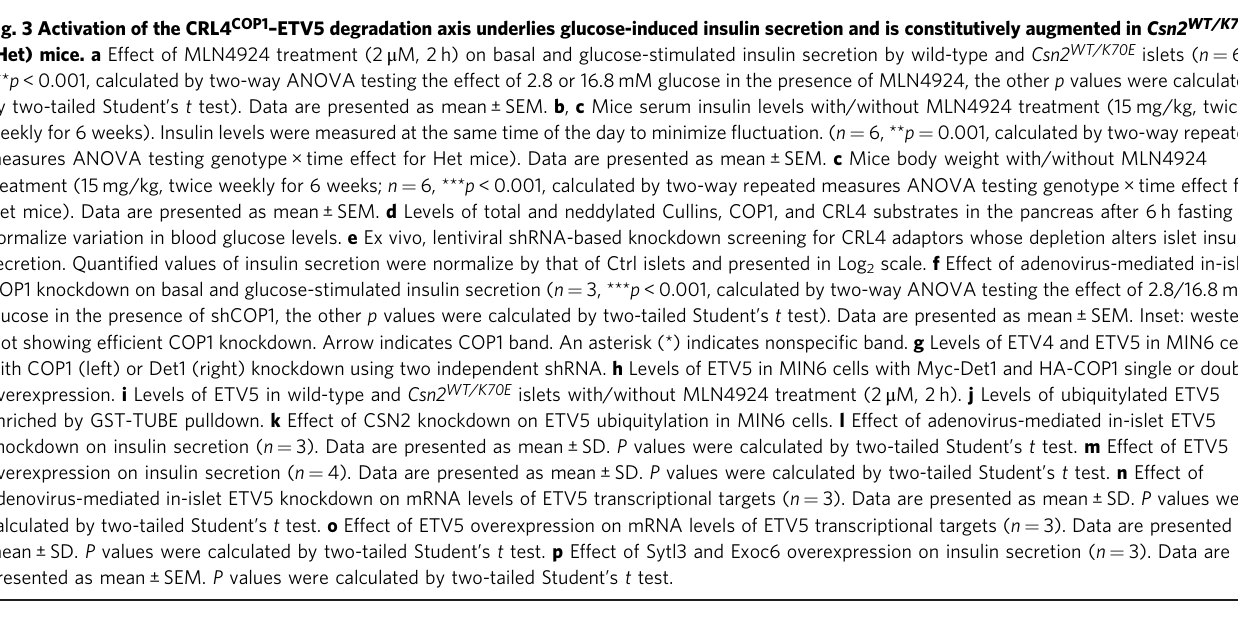
Fig. 3 Activation of the CRL4 COP1 – ETV5 degradation axis underlies glucose-induced insulin secretion and is constitutively augmented in Csn2